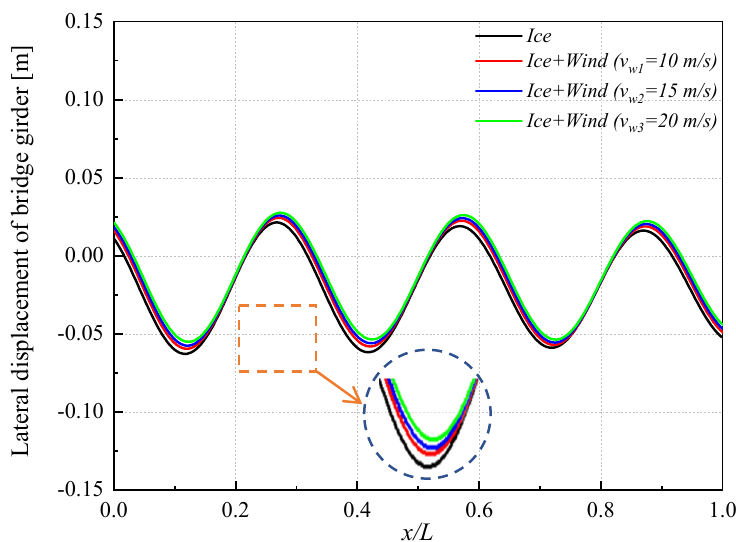
Figure 15. Lateral displacement of bridge girder under combined ice and wind loads.